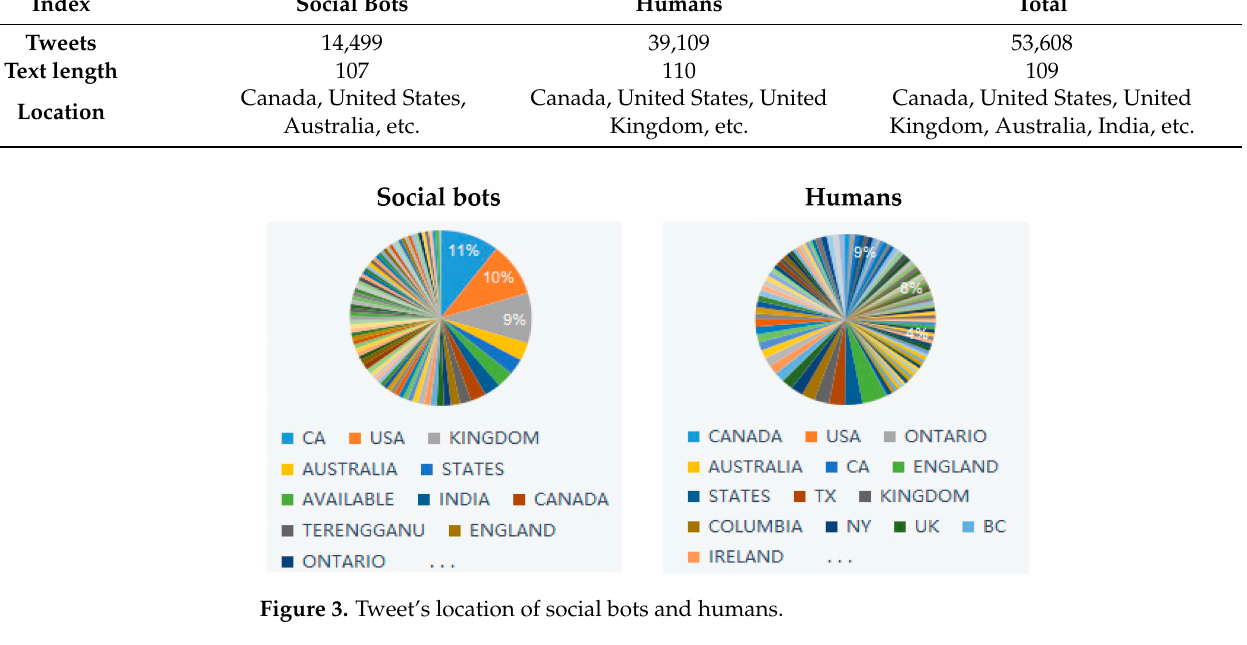
Figure 4. Frequency distribution and cumulative distribution of Twitter account bot score. 4.2. Topic Analysis Using natural language processing, we analyze high-frequency words, topics, and sentiment of tweets posted by social bots. We use R language to process the raw data. By analyzing tweets content, we find that social bots and humans focus on COVID-19 pan- demic and they both seem quite passionate about this topic. However, the focus of the two is also different. Specifically, humans are more concerned about topics that are closely related to human beings, such as people’s lives, inter-city mobility, and drug treatment. Words, such as “people” and “convoy”, have become the focus of humans. Social bots are more concerned with news topics related to the real-time evolution of the epidemic, such as confirmed cases, mortality, data analysis, and vaccine research. Words, such as “case,” “country,” and “analytics”, are the focus of social bots. Figure 5 shows the word cloud and the top 15 high-frequency words of the contents published by humans and social bots. Topics for humans are scattered and evenly distributed, while topics for social bots are ladder-like, which shows that the topics that humans care about are broad and scattered, while the topics that social bots care about are relatively few and clustered.